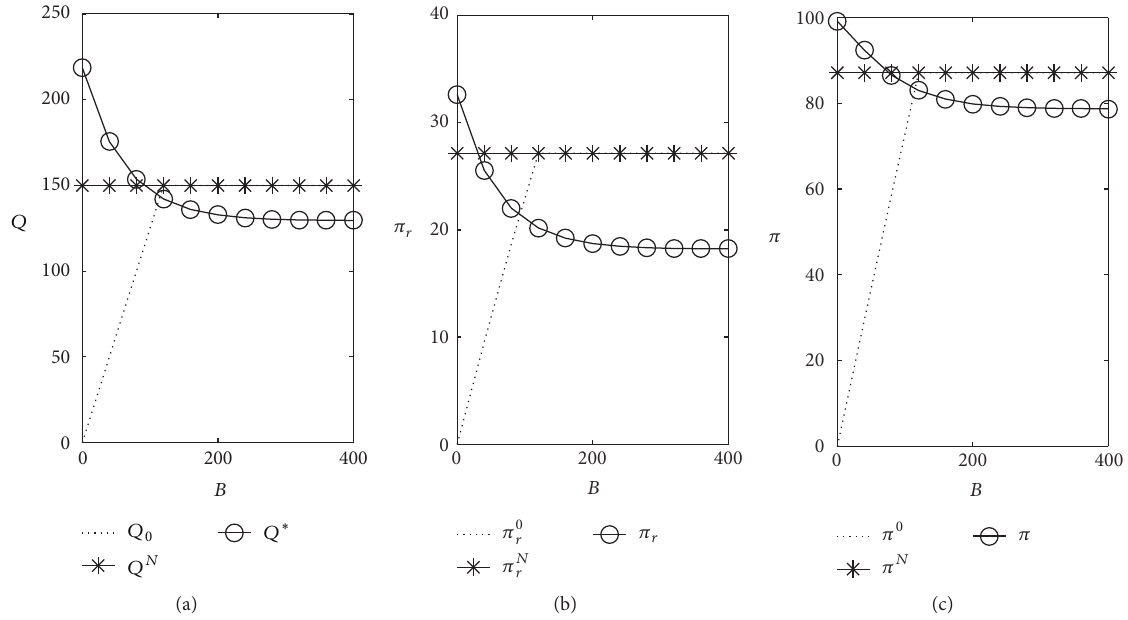
Figure 5: Impact of initial budget 𝐵 on ordering and